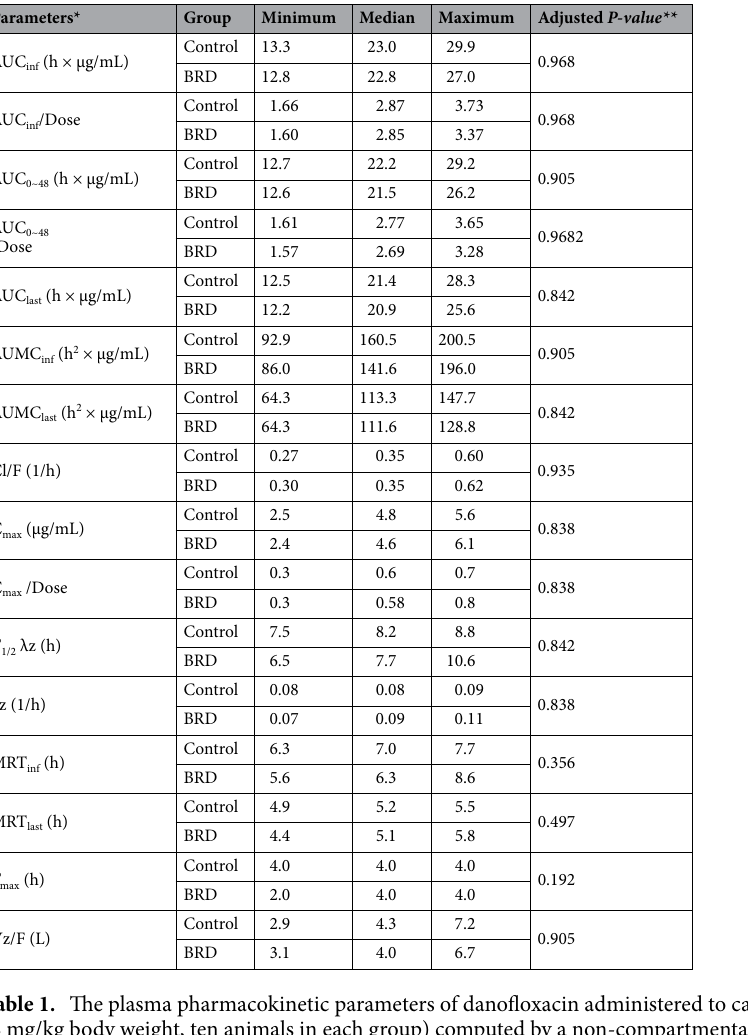
Similarly, the fecal PK values show that danofloxacin had higher total fecal concentration, peak concentration, and elimination half-life (AUC